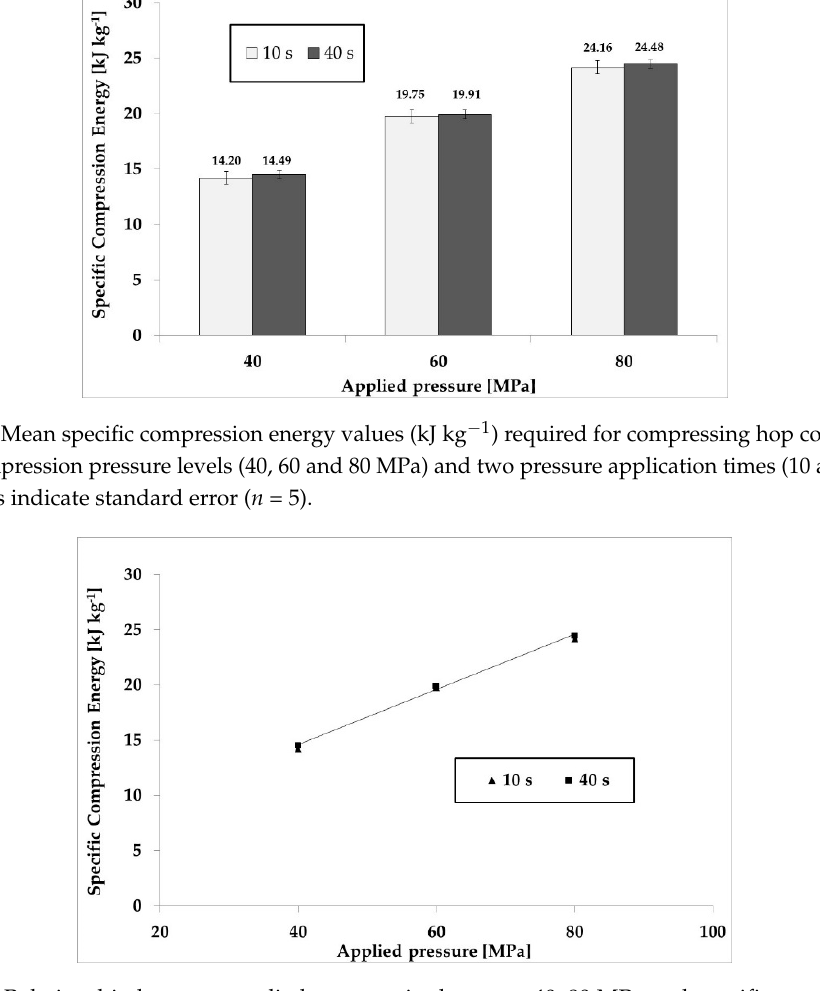
Figure 8. Relationship between applied pressure in the range 40–80 MPa and specific compression energy (kJ kg − 1 ) obtained during compression test at different pressure application times (10 and 40 s).